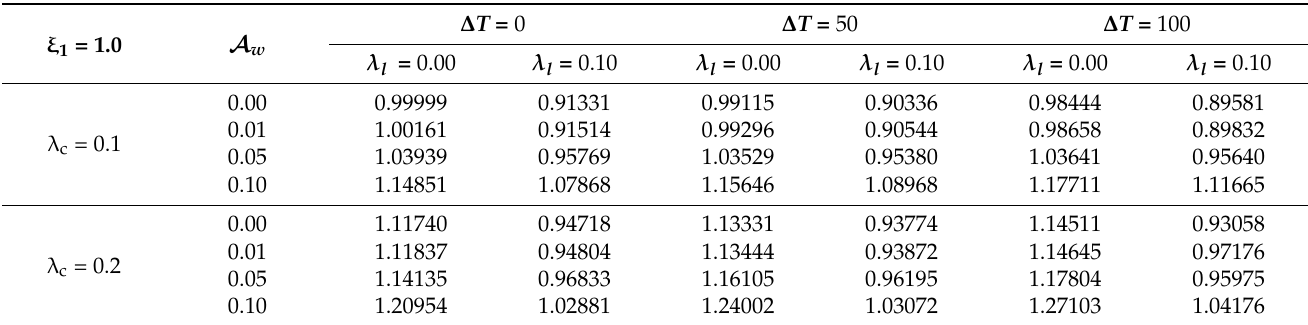
Table 17. Nonlinear dimensionless natural frequencies of porous FG clamped–clamped (C–C) nano- beam for ξ 1 = 1.0 in the case of Third-Order Hamiltonian